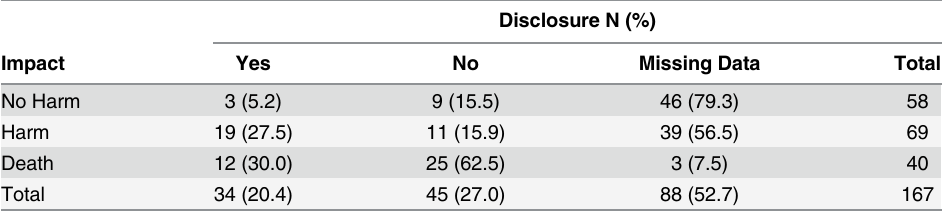
Table 5. Disclosure Status Classified by Impact of Error. Errors where the impact is not known are excluded, as are errors where disclosure was classified as not applicable.